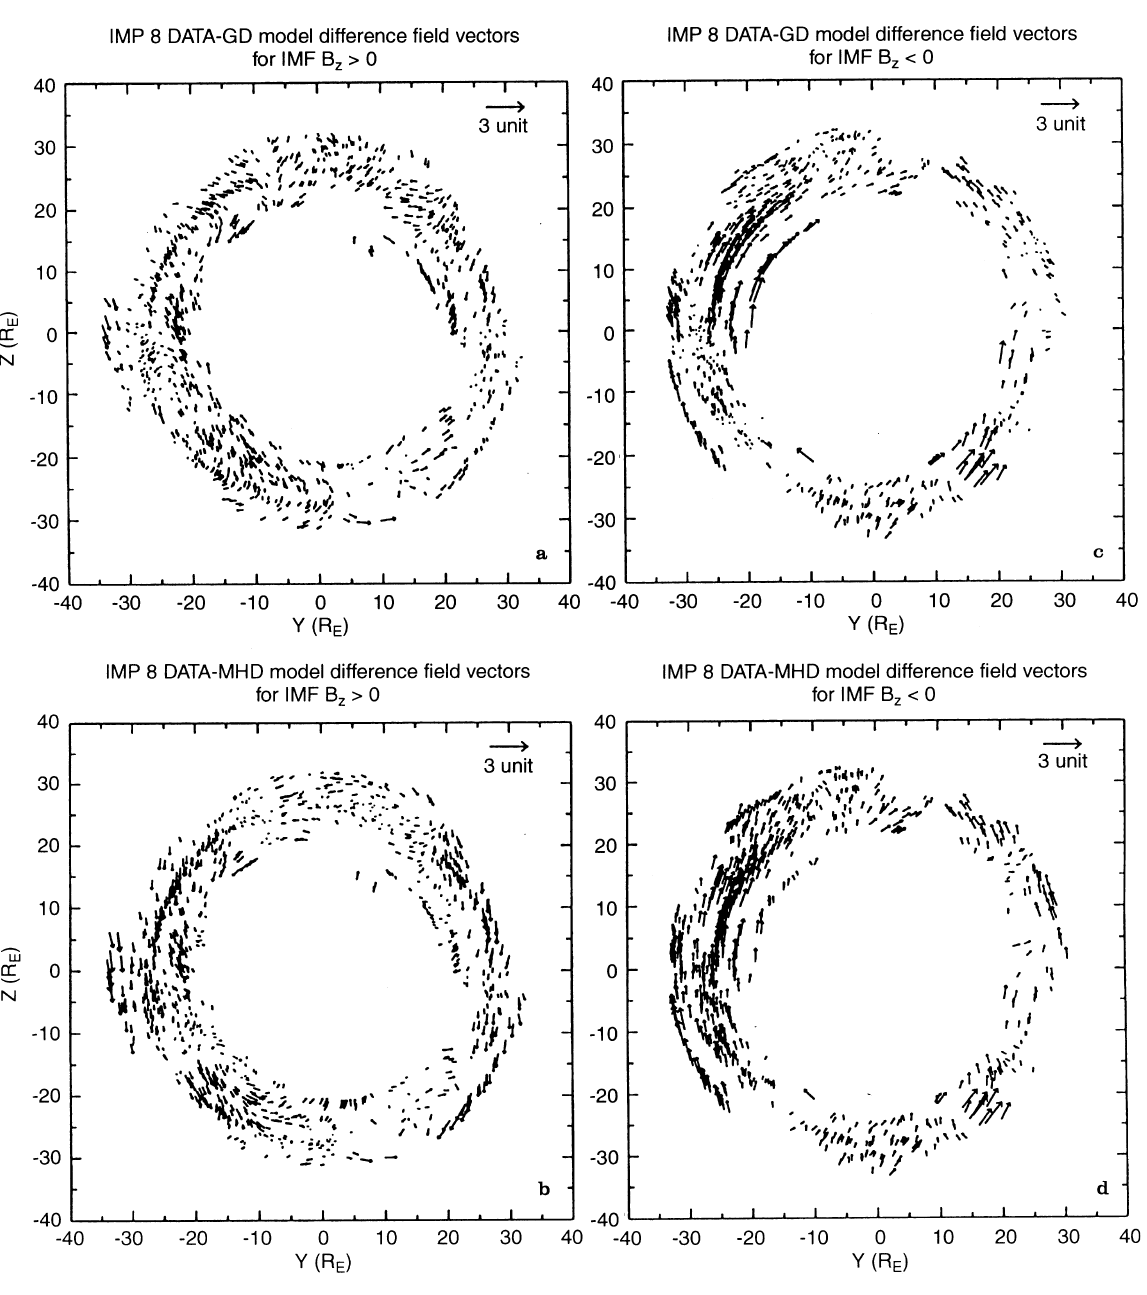
Fig. 2a-d. Upper panels : IMP 8 and gas dynamic model di(cid:128)erence vectors for a northward IMFs, b southward IMF di(cid:128)erence vectors after 22% reduction as described in the text. Lower panels : IMP 8 and MHD model di(cid:128)erence vectors for c northward and for d